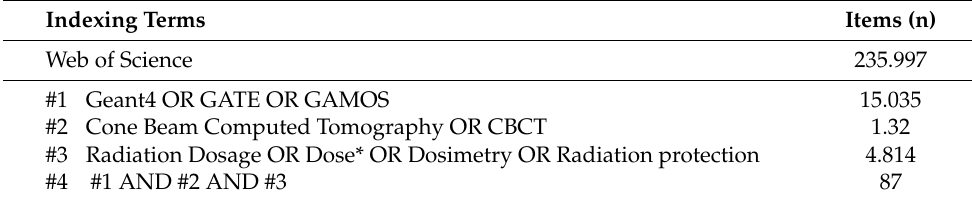
Table 1. Search strings, keywords, and items per